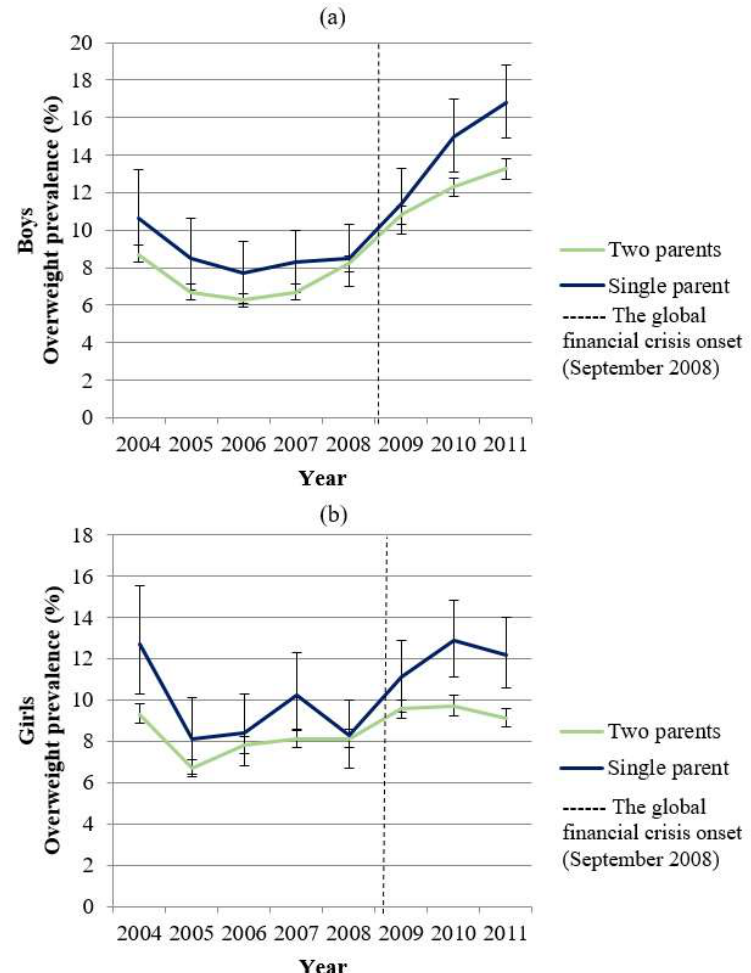
Figure 2. ( a ) Trajectory of overweight prevalence among boys by single parent status; ( b ) Trajectory of overweight prevalence among girls by single parent status. Error bars represent 95% confidence intervals.